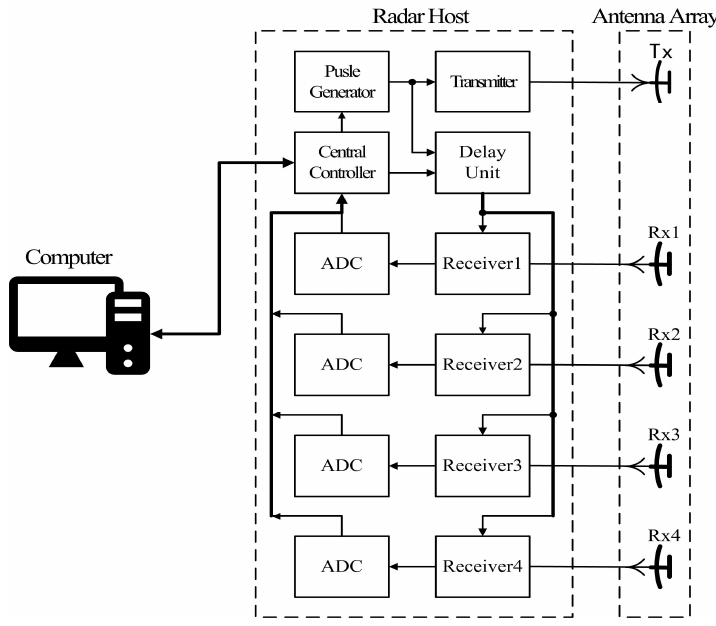
Figure 1. Systematic diagram of the multistatic UWB radar.